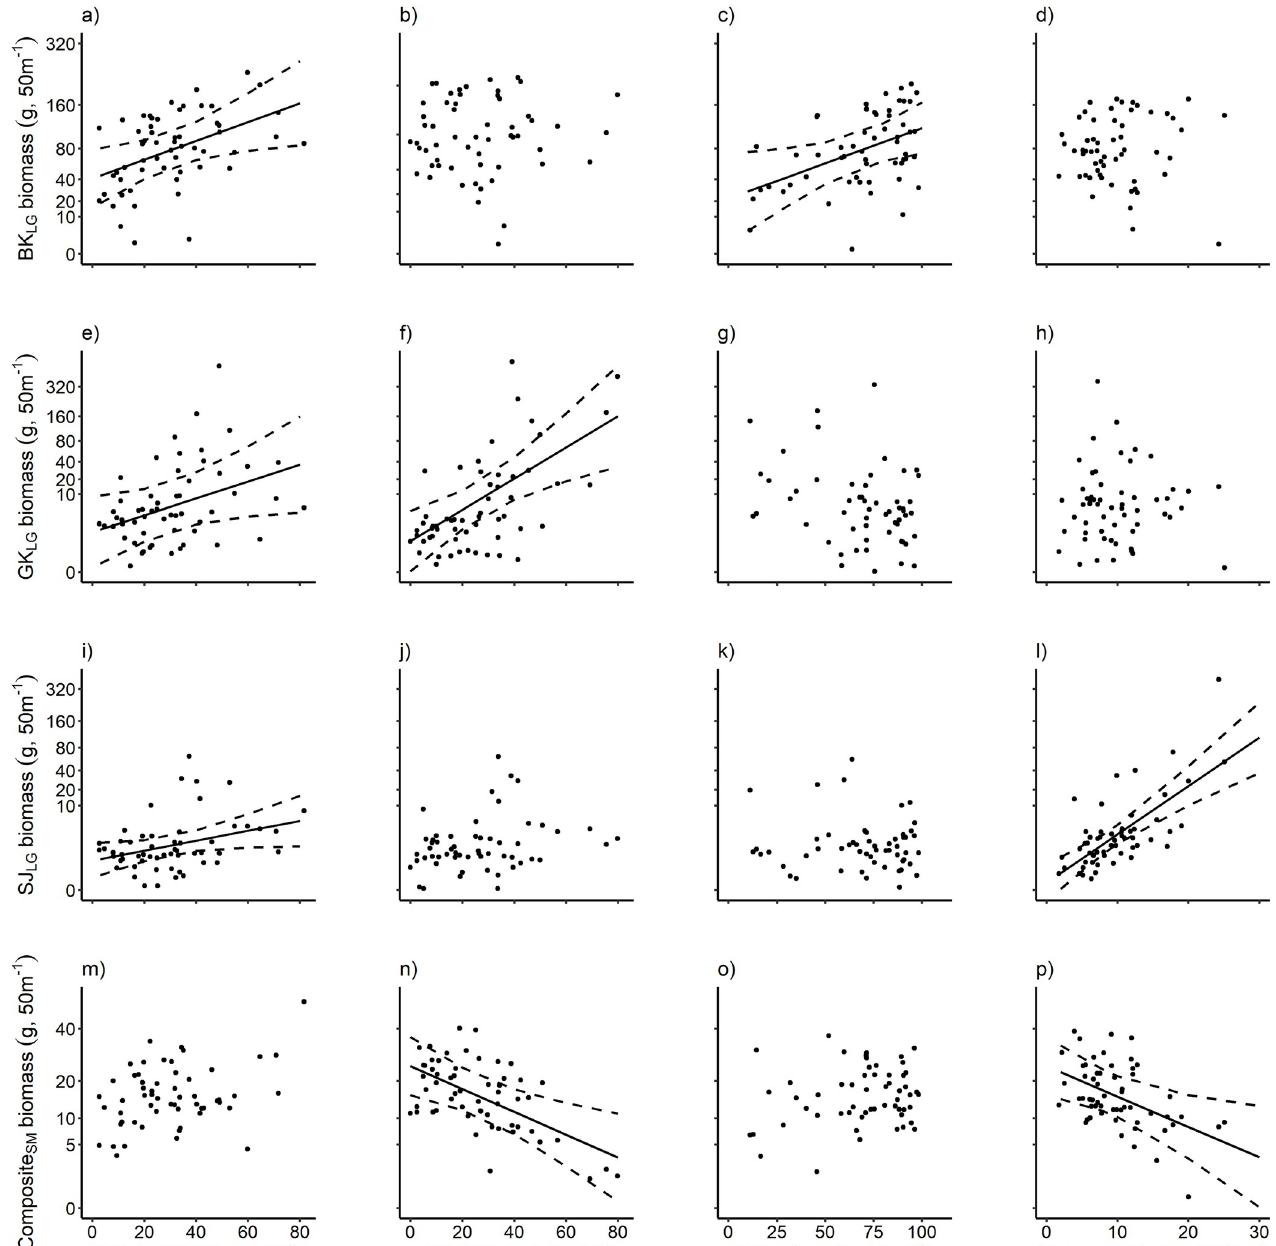
Fig 1. Independent effects of habitat features on k ō kopu biomass. Partial regression plots of the association between total pool volume, total bank cover, mean forest cover, and mean substrate size and the biomass of large banded k ō kopu (BK LG ; a-d), large giant k ō kopu (GK LG ; e-h), large shortjaw k ō kopu (SJ LG ; i-l), and composite small k ō kopu (Composite SM ; m-p) size classes within each 50-m reach. Note that Y-axes are not linear. Lines of best fit are shown where a significant association was found (P < 0.05) and error bands show 95% confidence intervals determined from model